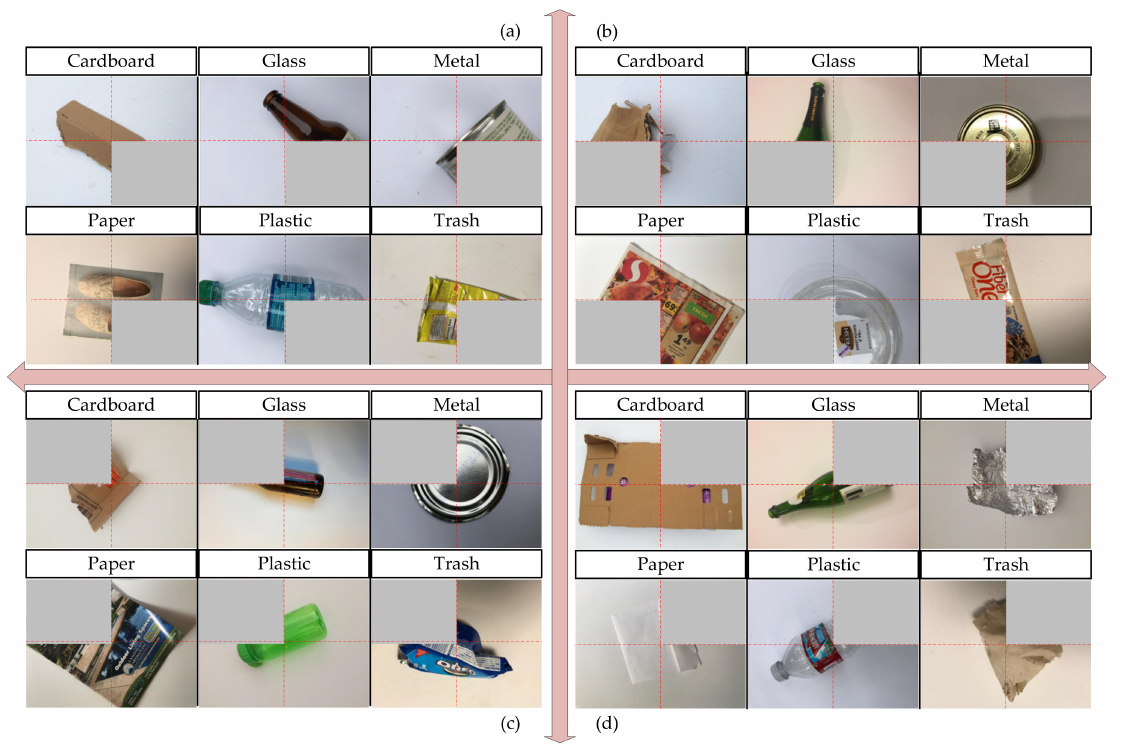
Figure 12. Some examples of occlusion in the TrashNet test set. ( a ) The lower right corner is occluded; ( b ) the lower left corner is occluded; ( c ) the top left corner is occluded; ( d ) the top right corner is